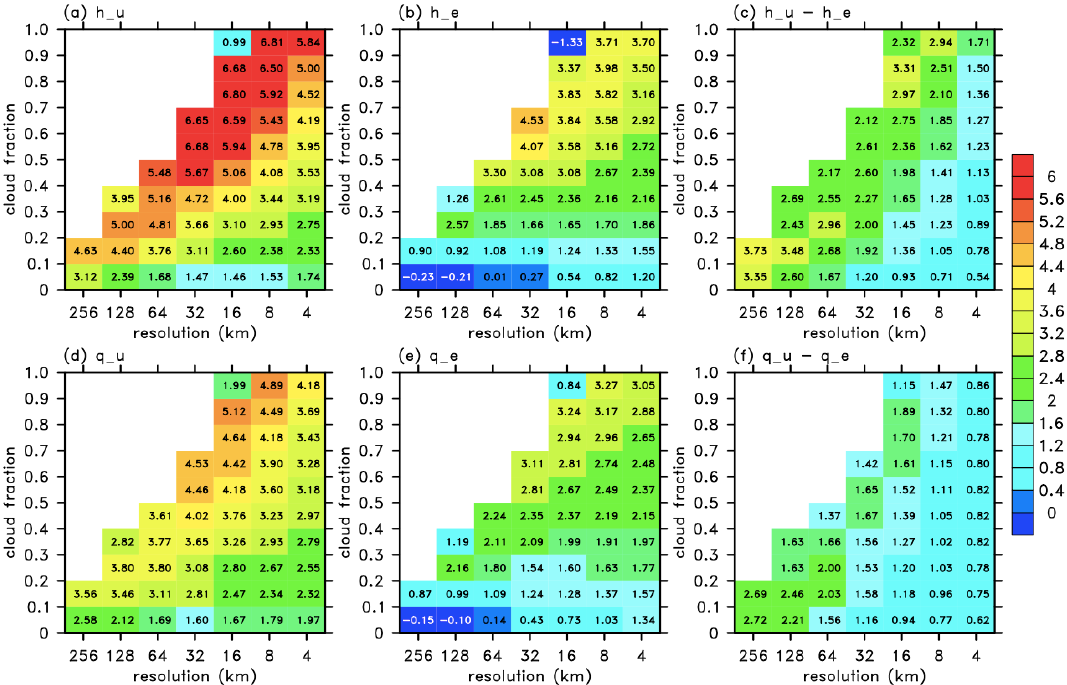
Figure 5. Moist static energy (top panel) and specific humidity (bottom panel) in ( a , d ) updrafts, ( b , e ) environment, and ( c , f ) their difference as functions of cloud fraction and subdomain size at the 500 hPa height. h and q are deviations of moist static energy and specific humidity from their time averages. h is normalized by 1/ C p and q is normalized by L / C p so that both have the units of Kelvin.